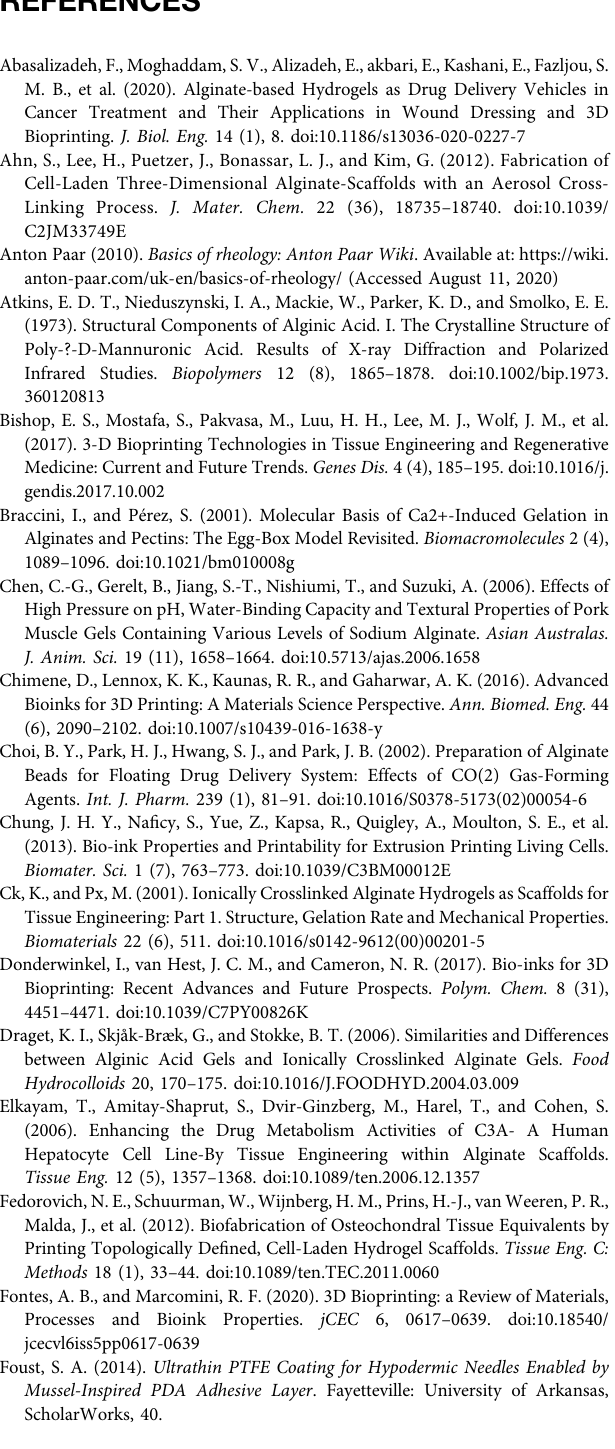
Supplementary Figure S3 | Illustration and video of the 3D bio-printing process producing an acellular ring. An acellular ring (6 layers) with the CaSO 4 pre- crosslinked MVM alginate without subsequent CaCl 2 post-crosslinking was 3D bio-printed for demonstrative purposes that our bio-ink can retain its structure as a free-standing fi lament, photograph and video of the printing process are